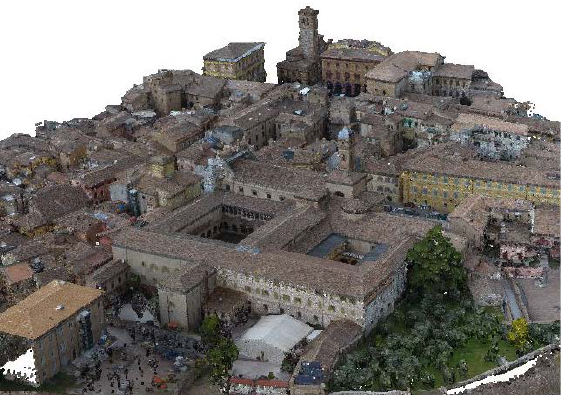
Figure 4. 3D point cloud obtained from the integrated survey.